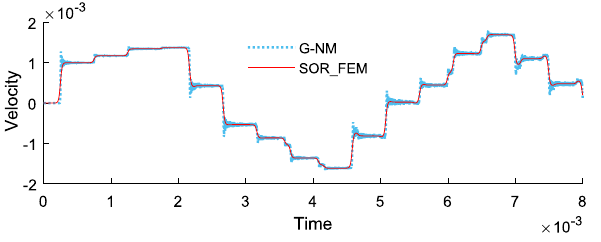
Figure 20. Time history of velocity at the region 2 center.